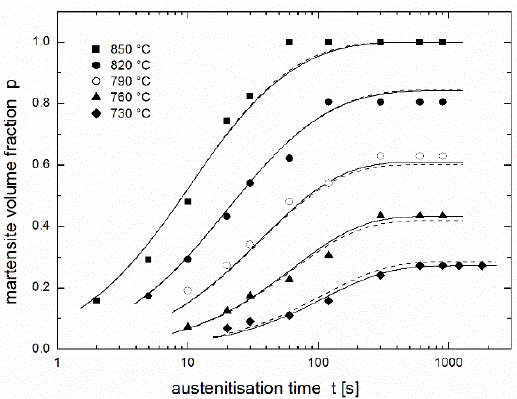
Figure 6. Martensite volume fraction in dual phase steel after austenitisation at various temperatures during various dwells [17]: comparison of fits using the equation of autoinhibition and the Arrhenius equation in a modified form (11) (full lines) and the form of (2) or (8) (dashed lines).